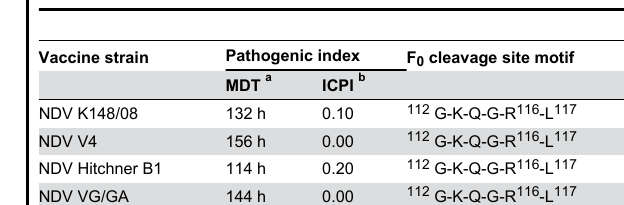
Table 1. Pathogenic index and molecular analysis of NDV K148/08 strain compared with commercially available NDV vaccine strains.